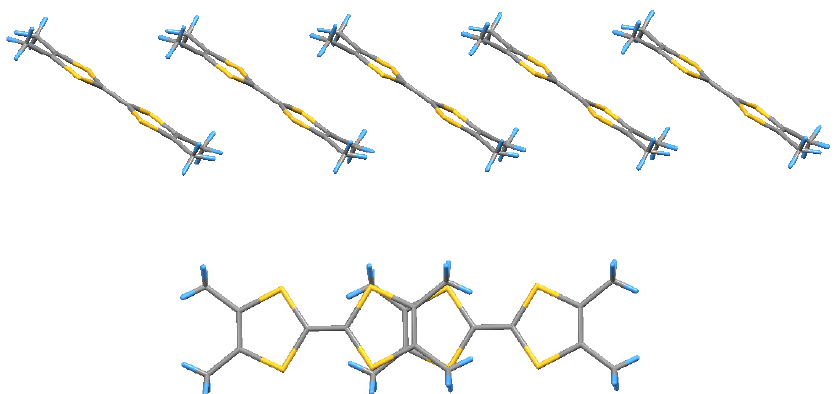
Figure 4. Crystal packing fragment of ( 2 ). A view along the c axis. The unit cell is outlined. H atoms are omitted for clarity.